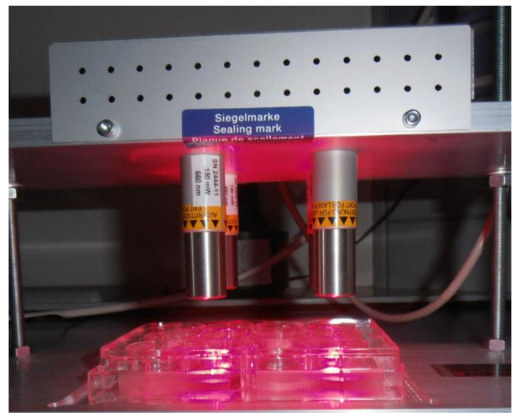
Figure 5. Photodynamic therapy (PDT) exposure after MB treatment. GaAlAs diode area laser sources were used parallel above four wells of a 12-well plate (FL 3500, 660 nm, 350 mW, Heltschl GmbH), 2 cm above the cell culture and the culture dishes were uncovered under the laser source. Control cells in the neighboring wells received scattered